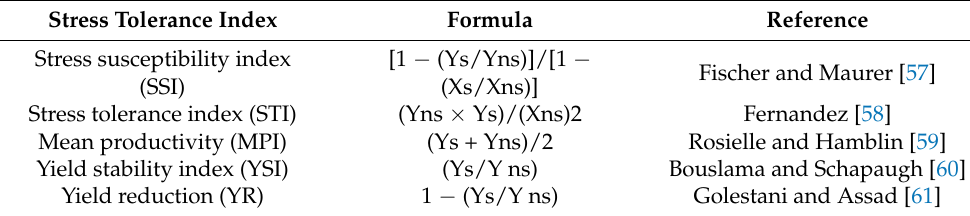
Table 1. Stress tolerance indices based on the fruit yield in this